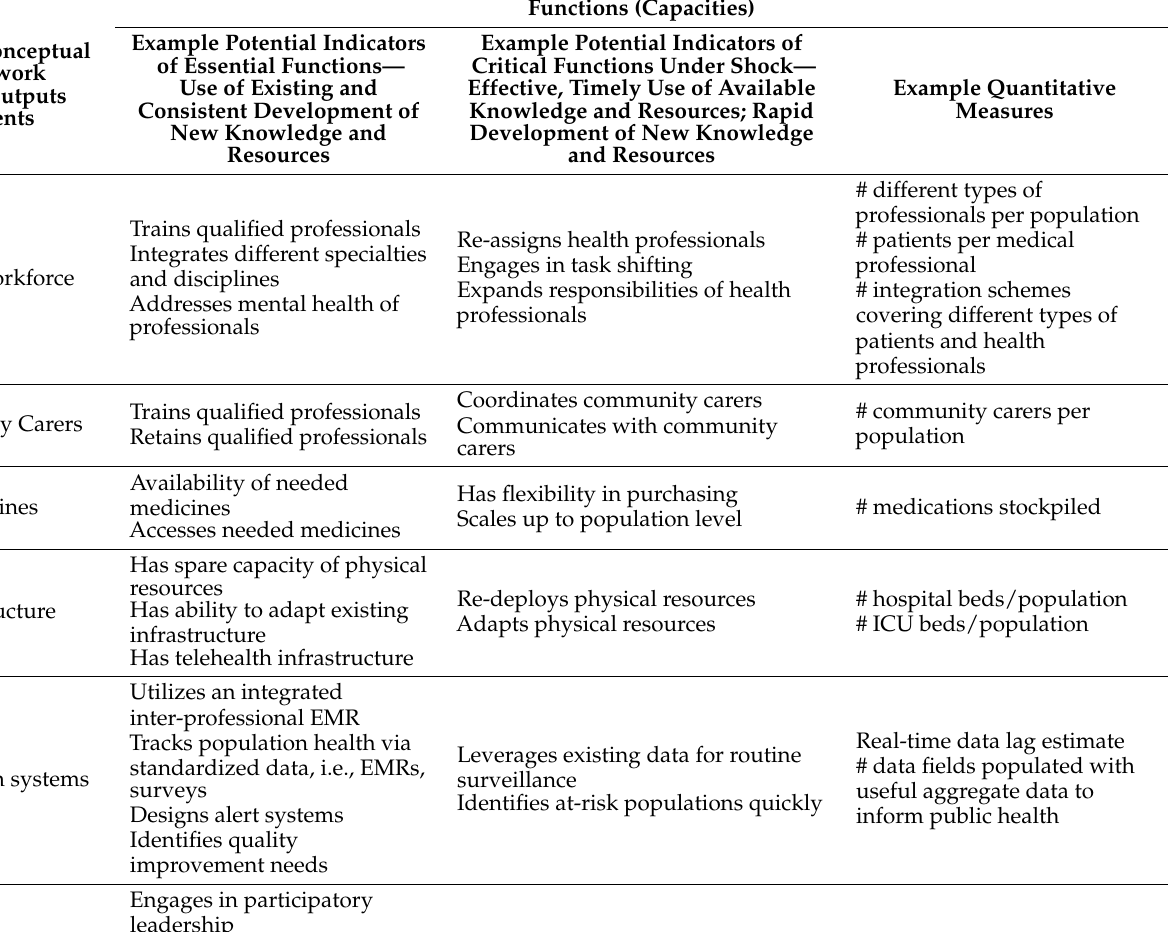
Table 4. Potential indicators for each MHSCS conceptual framework input/output